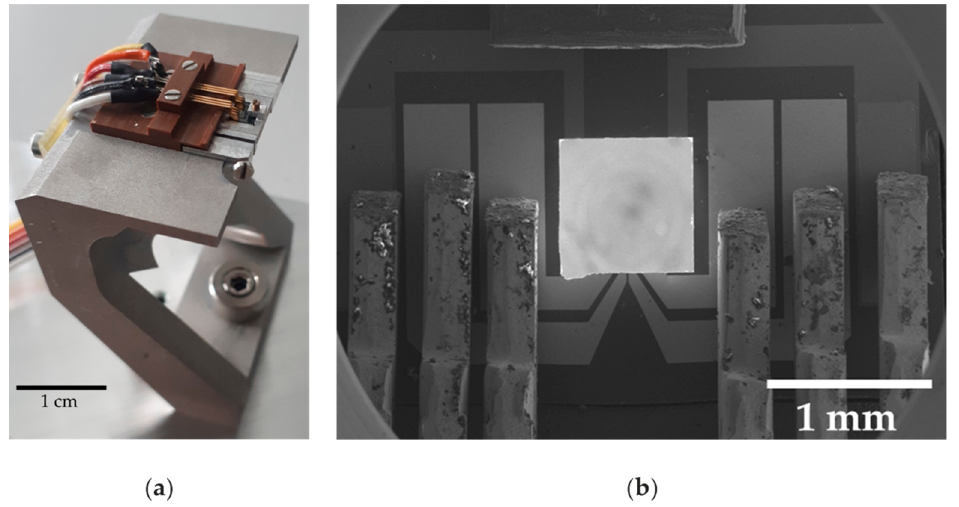
Figure 5. ( a ) Holder for mounting and using DENSsolutions 6-contact biasing-heating MEMS chips during reflection or transmission imaging in the SEM. ( b ) SEM image of a mounted test chip without SiN membrane.